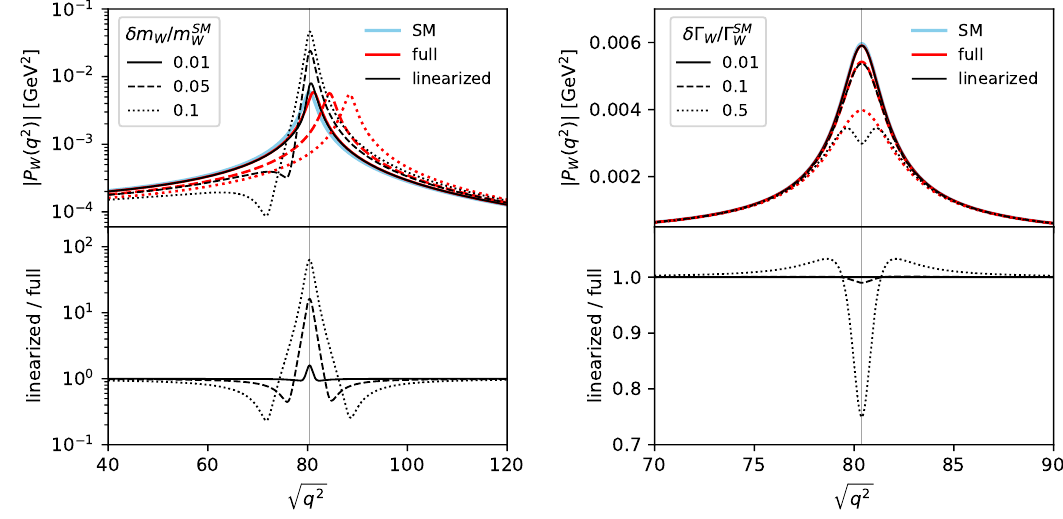
Figure 2 . Illustrative comparison of full and linearized W propagators varying δm W (left) and δ Γ W (right). The upper panels show the absolute value of the form factor of the transverse propagator p | P W ( q 2 ) | as a function of q 2 . Red lines are obtained modifying m W , Γ W in the full propagator, eq. (6.1), while black lines are obtained linearizing out δm Γ corrections as in eqs. (6.5), (6.6). W , δ W The lower panels show the ratio between the two curves. The thin vertical line marks p q 2 = = 80 . 387 GeV . The light blue curve in the upper plots marks for reference the SM behavior m SM W ( δ Γ = 0 = δm ). Solid, dashed and dotted lines correspond to three different sizes of δm and W W W δ Γ W , with the same coding in upper and lower panels. In the right panel, the black, red and light blue solid lines are